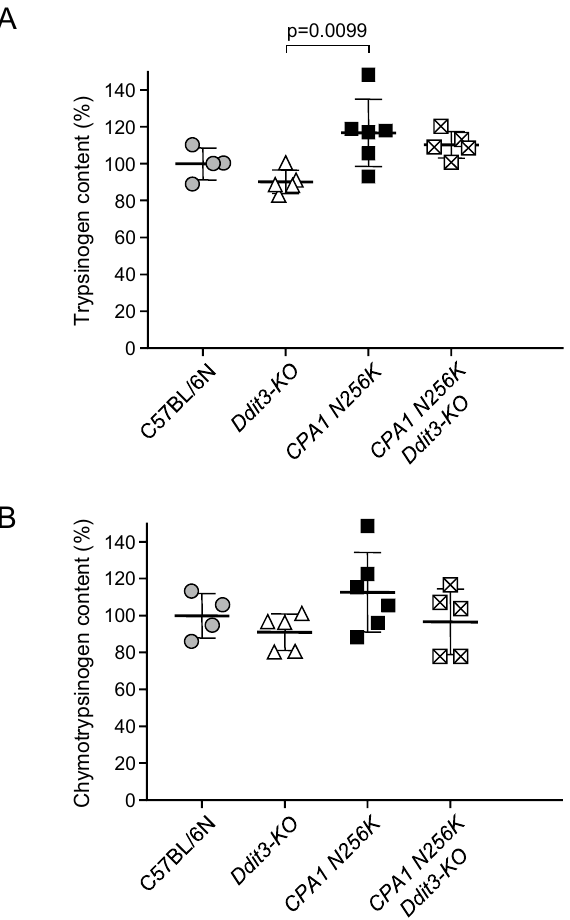
Figure 3. Protease zymogen content of the pancreas from CPA1 N256K × Ddit3-KO mice. ( A ) Trypsinogen, and ( B ) chymotrypsinogen content was measured from pancreas homogenates of 1-month-old C57BL/6N, Ddit3-KO , CPA1 N256K, and CPA1 N256K × Ddit3-KO mice by enzymatic assays after full activation to trypsin and chymotrypsin. Results were expressed as percent of the average C57BL/6N values. Individual data points with mean (horizontal bar) and standard deviation are